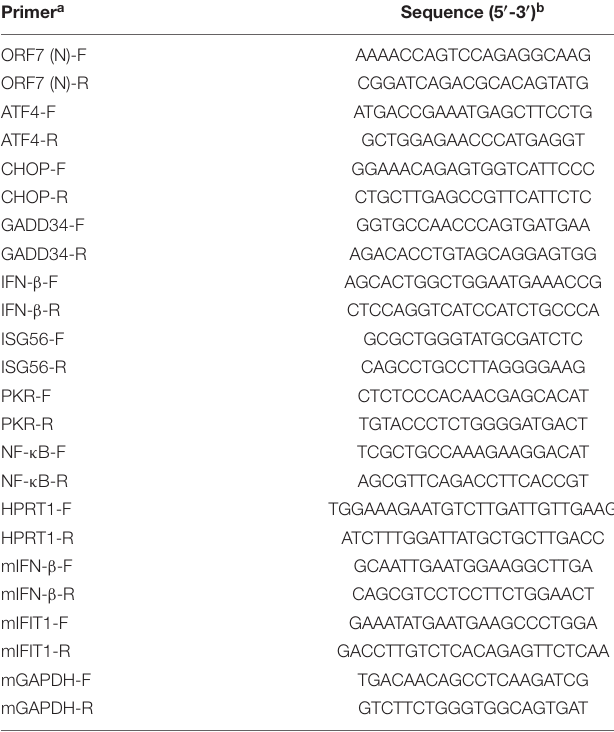
TABLE 1 | List of primers for